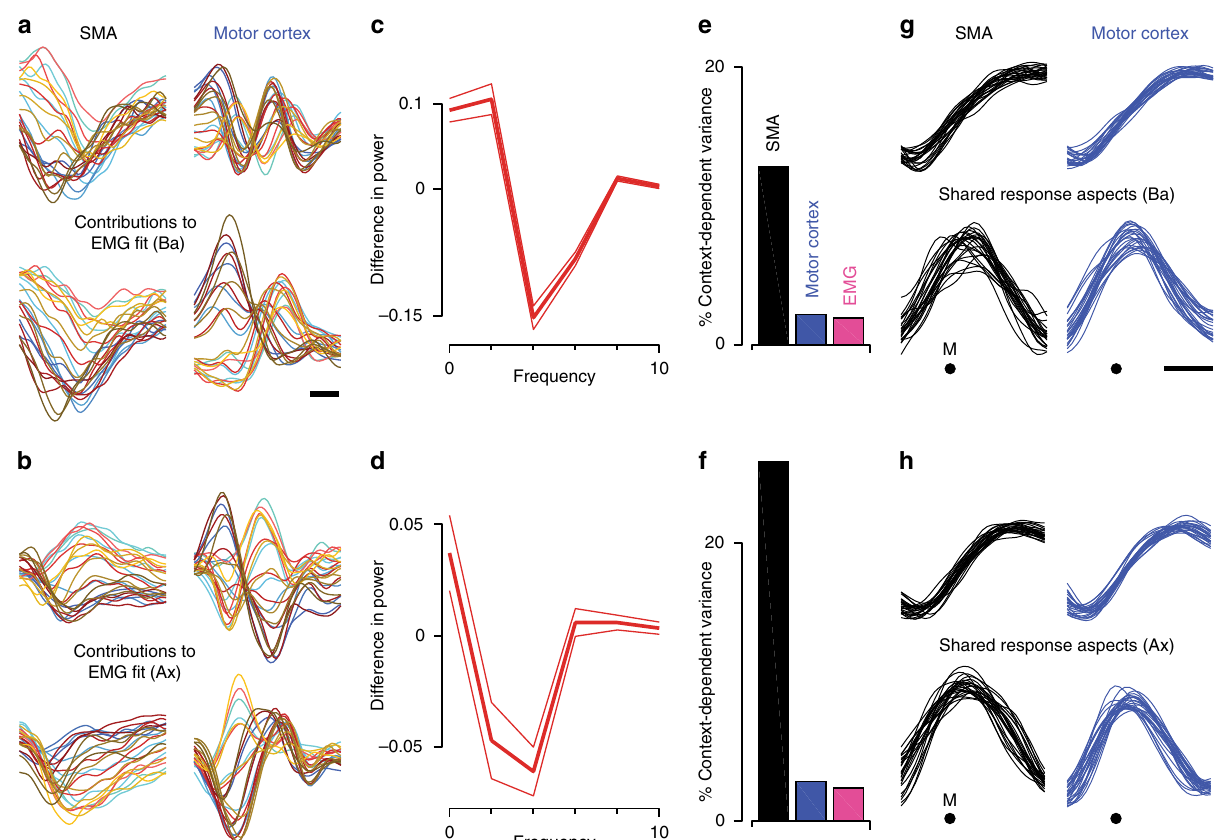
Fig. 8 Potential contributions to outputs and internal computations. a Relative contributions of SMA and motor cortex when fi tting muscle activity with neural activity. Analysis is based on the four dynamical dimensions for SMA, motor cortex, and the muscles. Activity in each EMG dimension was regressed against eight dimensions of neural activity, four each from SMA and motor cortex. The fi t was the sum of contributions from SMA and motor cortex, shown separately in the left and right columns. Average R 2 was 0.58. For visualization, contributions are shown for two of the four muscle dimensions, chosen to highlight the greater contribution of motor cortex to multi-phasic structure. Each trace corresponds to one condition, plotted versus time over a 500 ms period starting 150 ms before movement onset (scale bar shows 100 ms). Data are for monkey Ba. b Same analysis for monkey Ax. The average R 2 was 0.72. c Quanti fi cation of the effects illustrated in panel a . Difference in normalized power, between SMA and motor cortex contributions, as a function of frequency. Positive values indicate greater power in SMA, negative values indicate greater power in motor cortex. Averages are taken across all conditions, and across all four dimensions of the EMG activity being fi t. Flanking traces shown standard errors. d Same analysis for monkey Ax. e Percentage of total response variance due to activity varying with context. Data are for monkey Ba. f Same analysis for monkey Ax. g Response aspects that were most strongly shared between SMA and motor cortex, found via canonical correlation analysis. Dimensions were found within the space spanned by the six HDR dimensions, including the two condition-invariant dimensions and the four dynamical dimensions. Top and bottom rows plot the fi rst and second canonical correlates. These are plotted versus time around the time of movement onset (M). Each trace corresponds to one condition. Scale bar shows 100 ms. Data are for monkey Ba. h Same analysis for monkey